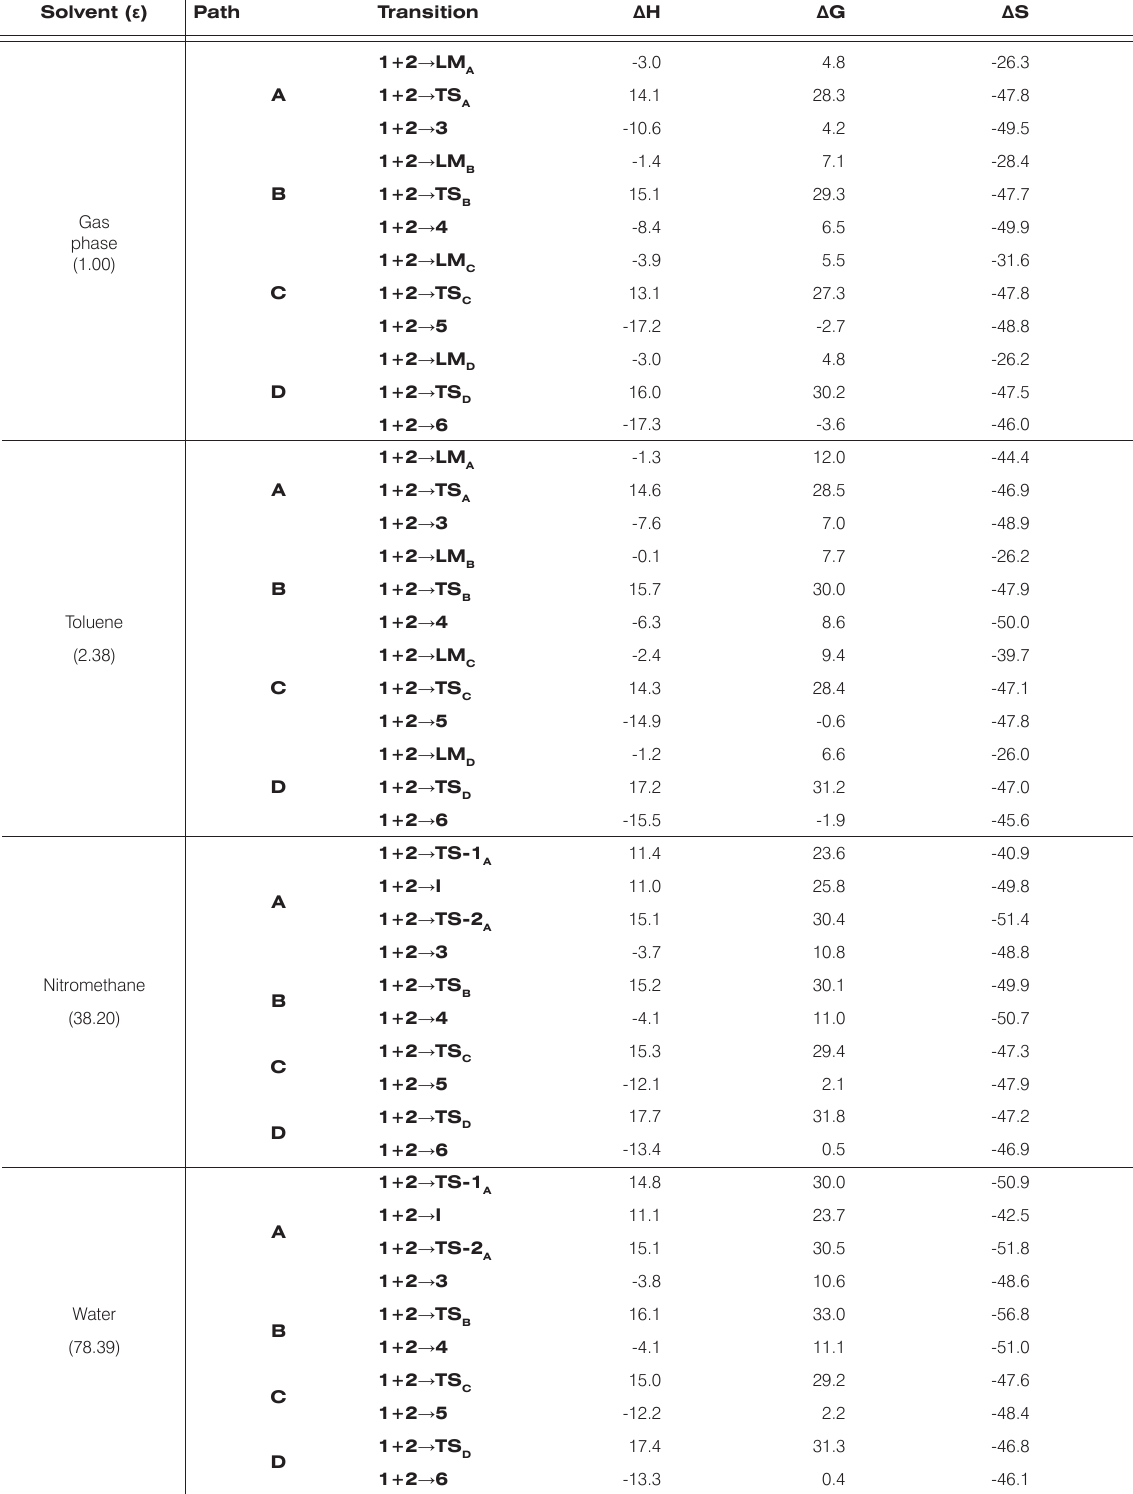
Table 2. Kinetic and thermodynamic parameters of [2+3] cycloaddition between a -phenylnitroethene 1 and (Z)-C,N-diphenylnitrone 2 according to B3LYP/6-31G(d) calculations (T=298 K; ∆ H and ∆ G values are in kcal mol -1 ; ∆ S values are in cal mol -1 K -1 ). Solvent ( ε